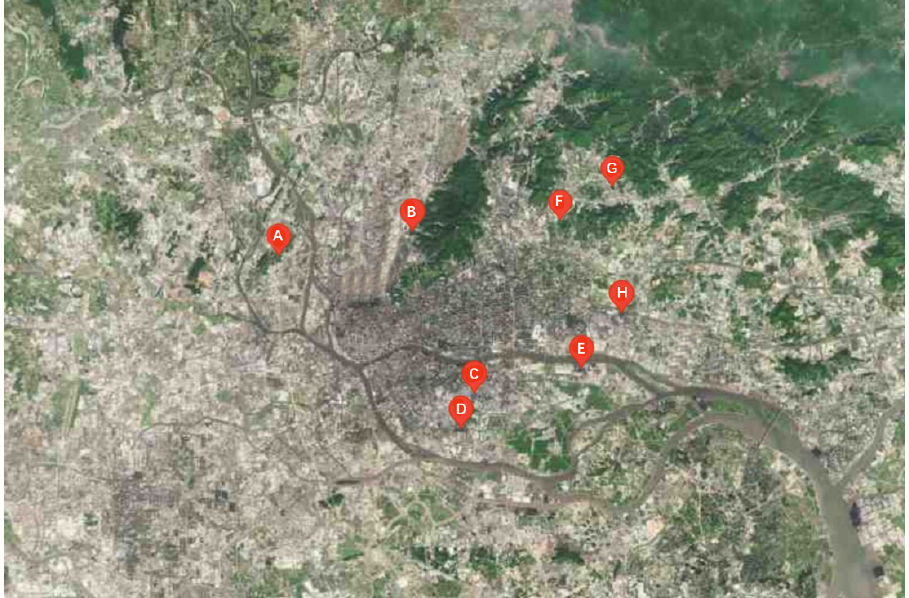
Figure 2. Battery swapping network in Guangzhou.